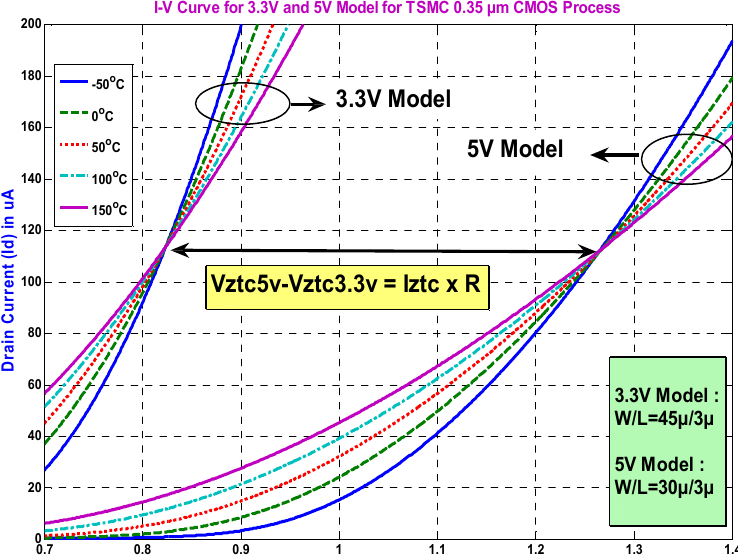
Figure 2. The design concept for DZTC voltage and current